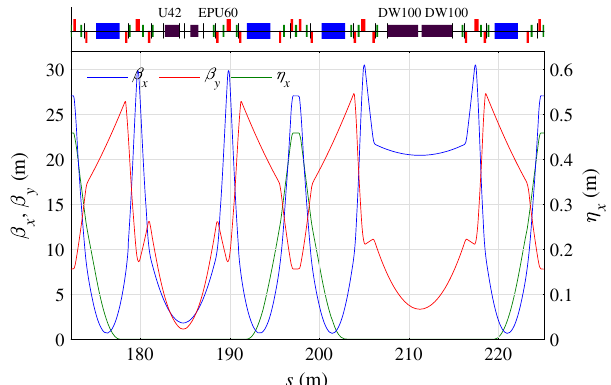
FIG. 1. Beta functions for 1 = 15 of NSLS-II (cells 7 and